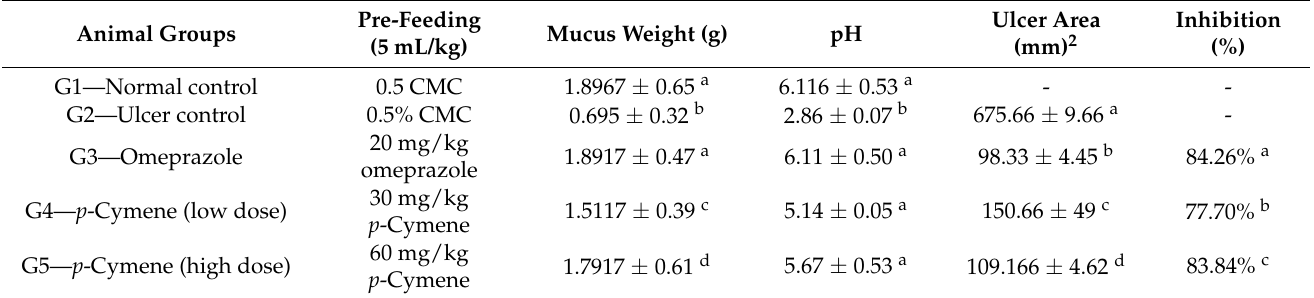
Table 1. Effect of the p -Cymene on mucus weight, pH of stomach, ulcer area, and inhibition percentage of ulcer area in ethanol-induced gastric ulcer